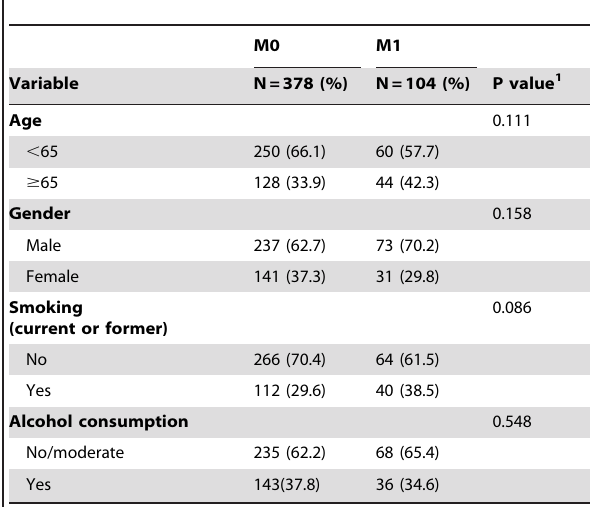
Table 4. Characteristics s in patients with metastasis and without